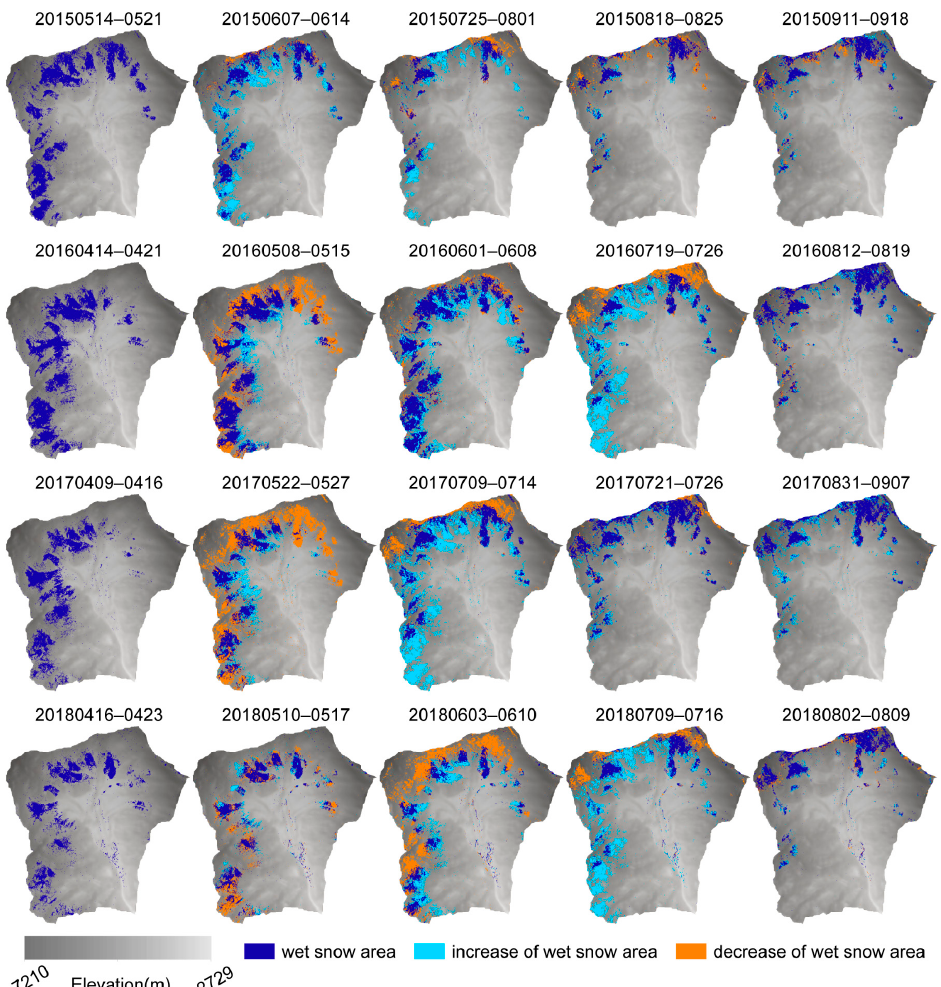
Figure 7. Maps of snowmelt area variations in the Sedongpu Basin. The SAR image dates used to detect the wet snow changes are marked on each map. Dark blue: the area of snowmelt on the marked date; light blue: the extent of the decrease in the snowmelt relative to the previous date; and orange: the extent of the increase in the snowmelt relative to the previous